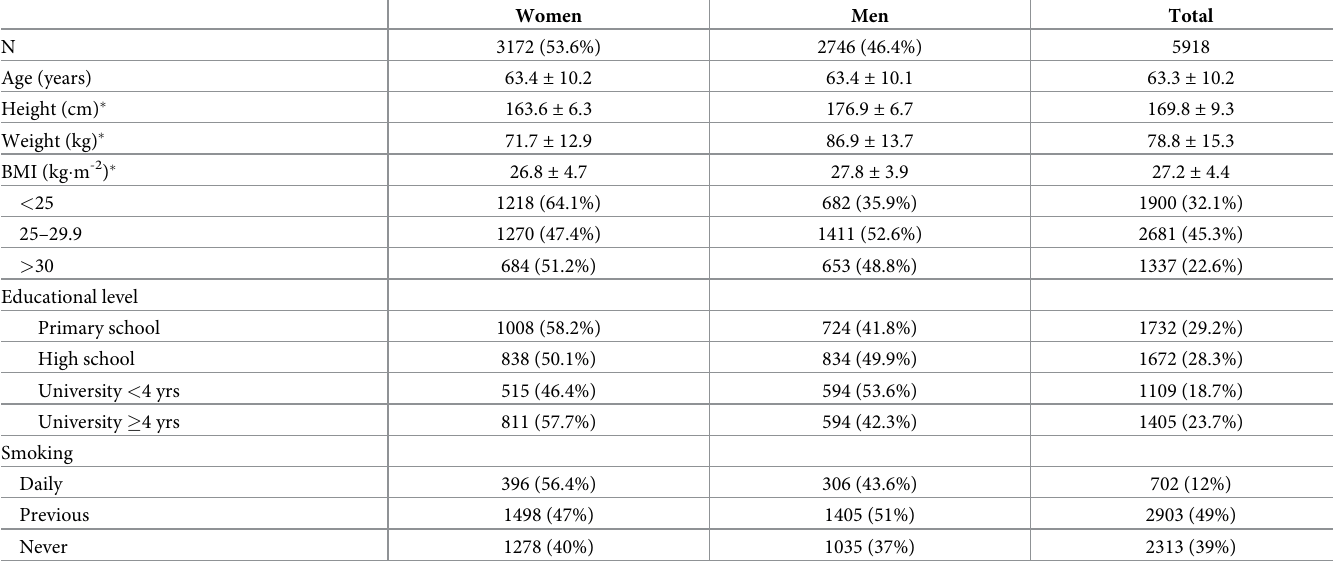
Table 2. Participant characteristics. The Troms ø Study accelerometry sample